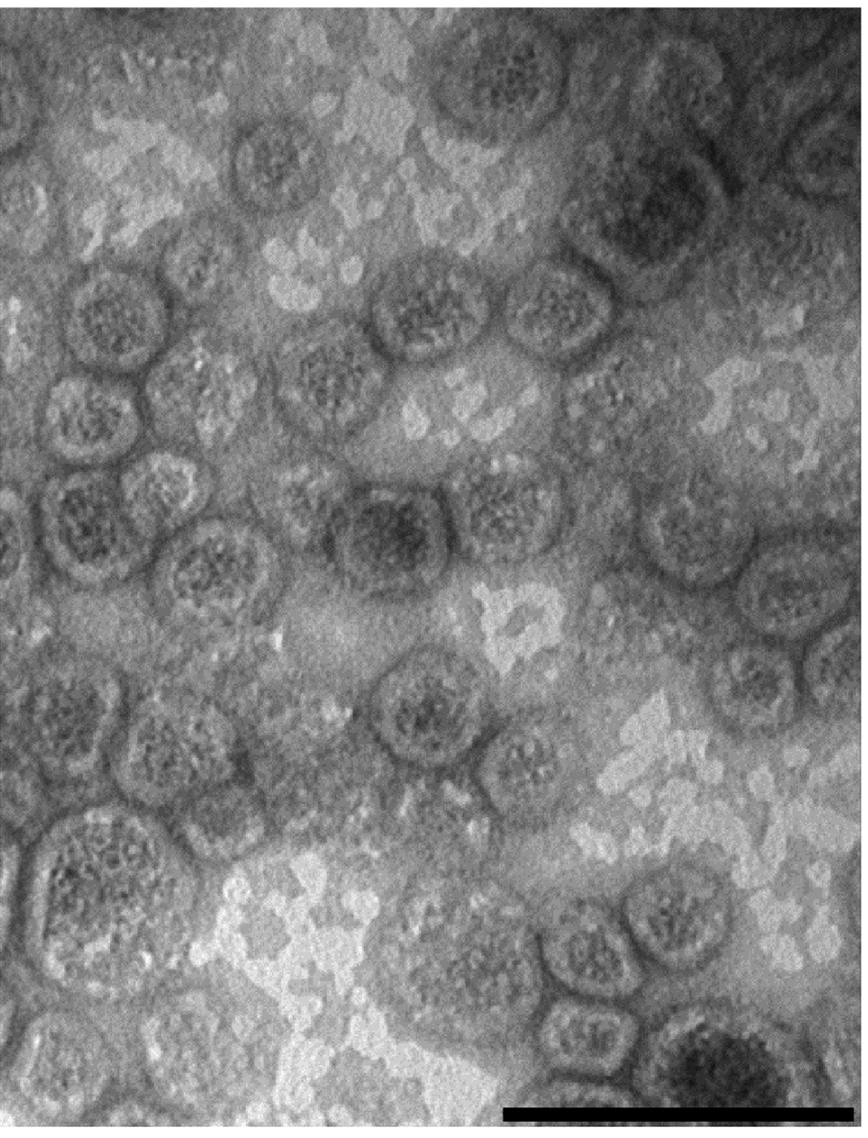
Figure 3. Electron microscopy of Shigellasonnei D tolR D galU GMMA. GMMA were isolated from the culture supernatant of S. sonnei –pSS D tolR D msbB by TFF, prepared for negative staining, and viewed by electron microscopy revealing the presence of well-organized membrane vesicles with a diameter of about 30–60 nm. Bar length =100 nm.